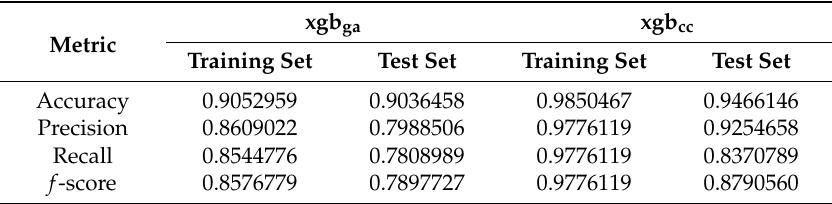
Table 9. Performance of best classifiers on training and test set.